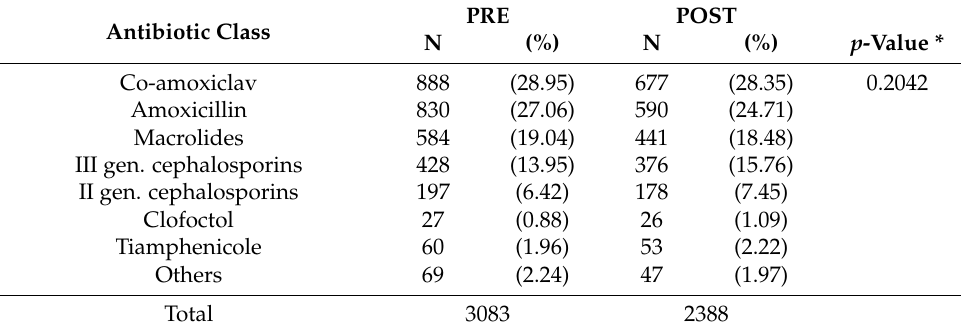
Table 3. Antibiotic prescriptions pattern in 1091 children included in the PRE and POST periods. Pedianet,